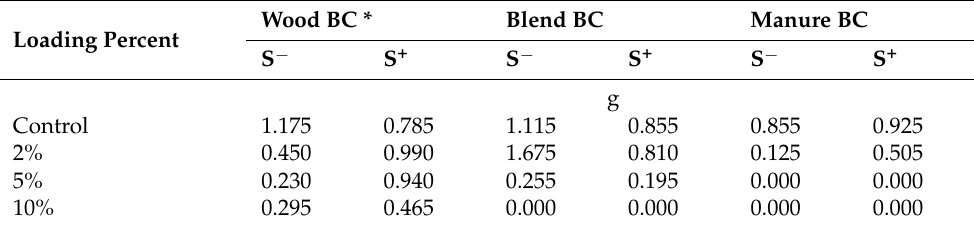
Table 4. Trifolium incarnatum root dry weight medians according to saturation and loading